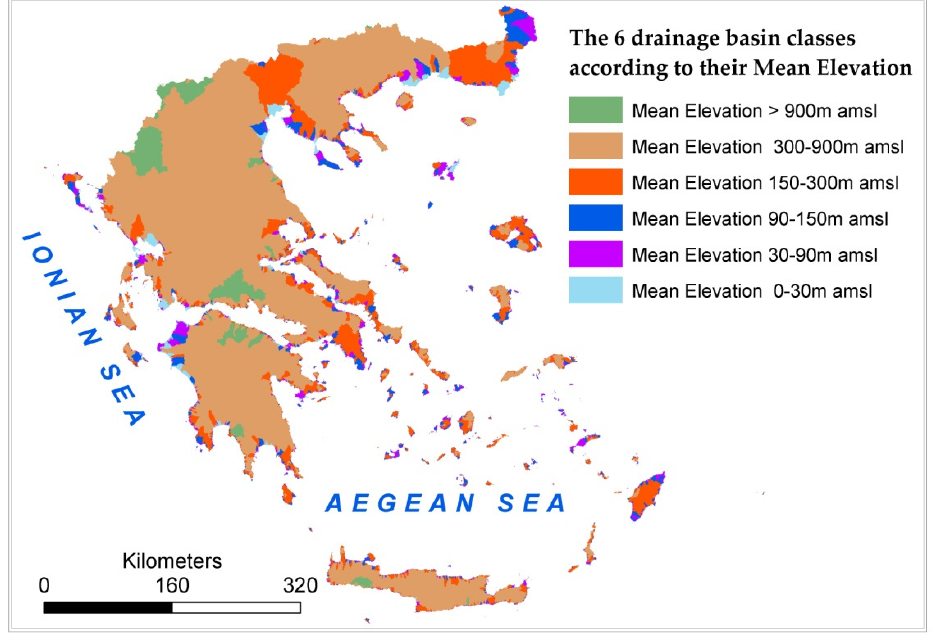
Figure 3. Drainage basins classification according to their mean elevation value.